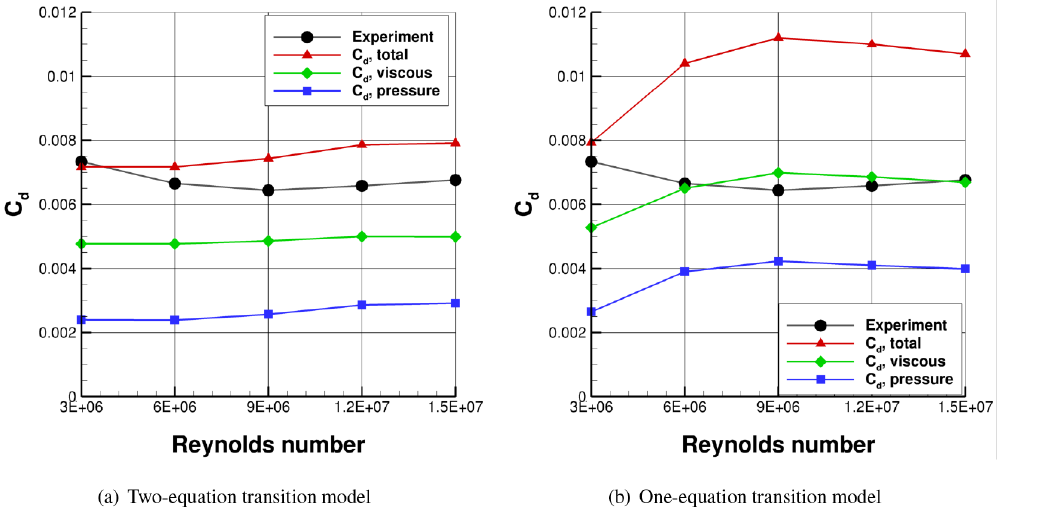
Figure 8. Drag coefficient breakdown for DU00-W-212 airfoil and comparison with the experiment at 4 ◦ angle of attack and various Reynolds